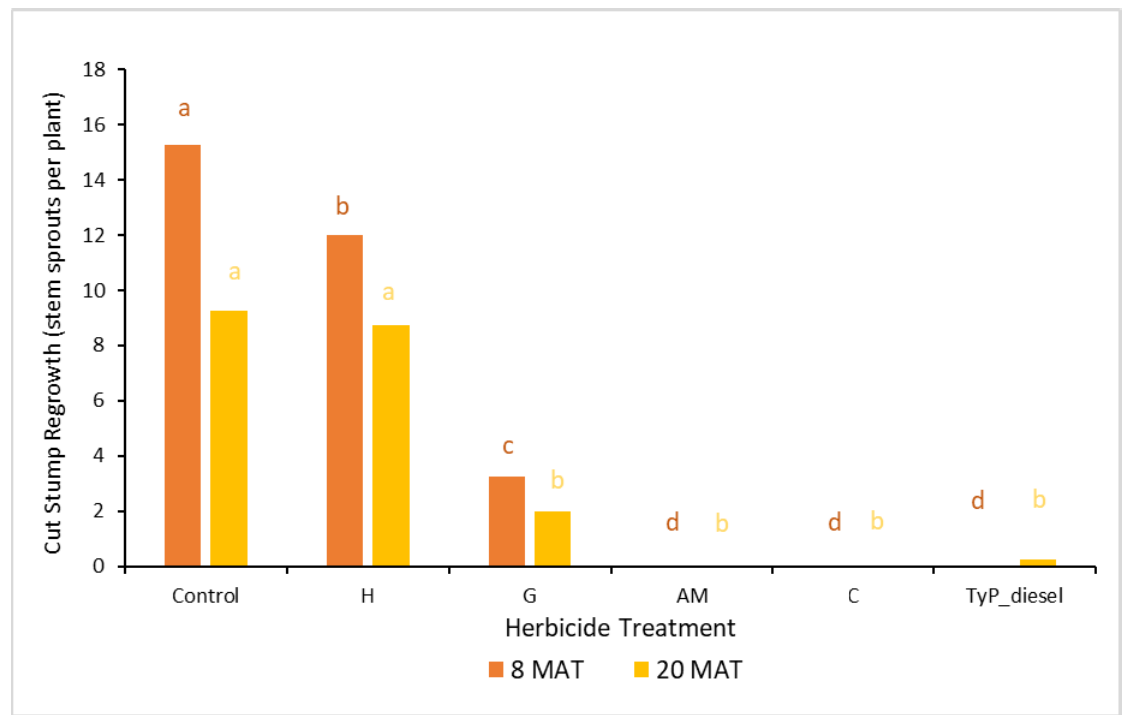
Figure 10. Average stem regrowth of mimosa bush 8 and 20 MAT following cut stump herbicide application in trial 4. H, hexazinone; G, glyphosate; AM, aminopyralid + metsulfuron-methyl; C, clopyralid; TyP_diesel, triclopyr + picloram mixed with diesel. For each monitoring time, columns with different letters indicate significant difference by Tukey’s test with 95% confidence.